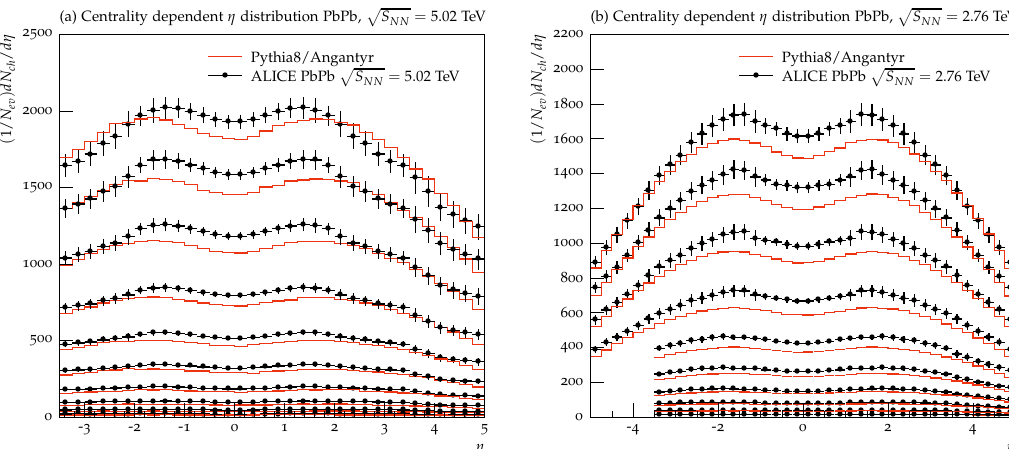
Figure 17 . The centrality dependence charged multiplicity over a wide (cid:17) range in PbPb collisions at p s = 5 : 02 TeV (a) and p s = 2 : 76 TeV (b). Both for centralities 0{5%, 5{10%, 10{20%, NN NN 20{30%. . . 80{90%. Data from ALICE